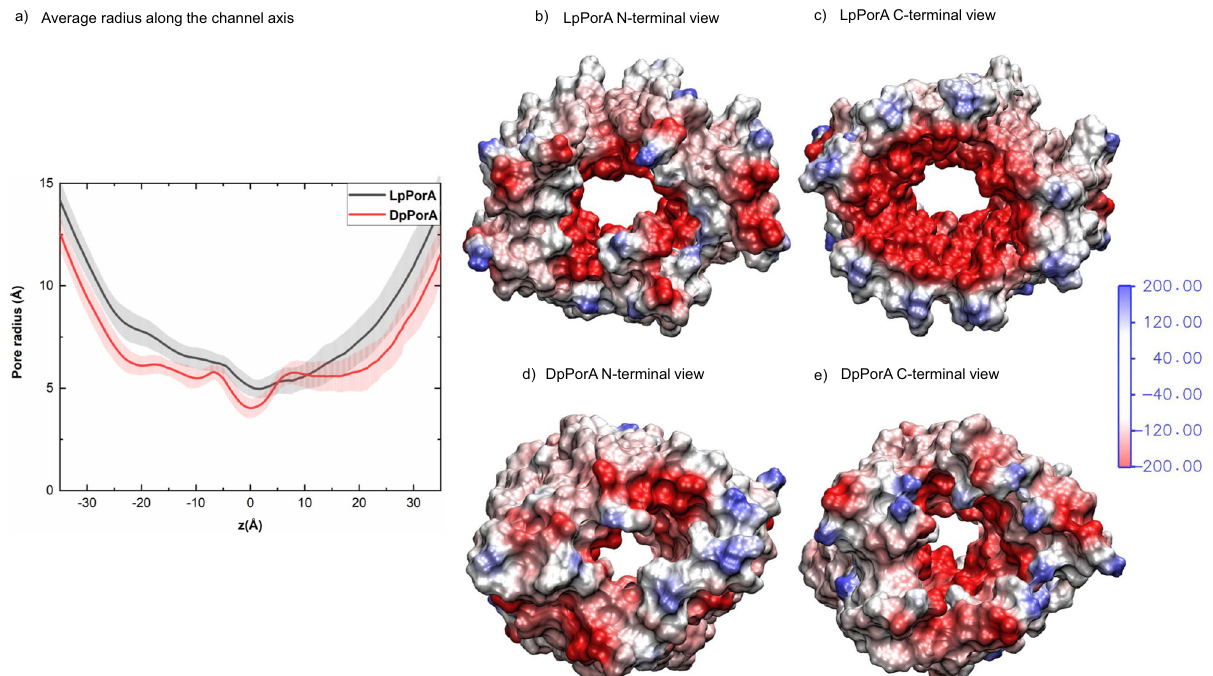
Fig.7|RadiusalongthechannelaxisandelectrostaticpotentialofDpPorAand LpPorA. a Radius pro fi le along the channel axis averaged over a trajectory also showing the standard deviations as shaded error bars. b N-terminal and c C-terminal view of the electrostatic potential map of the amino residues